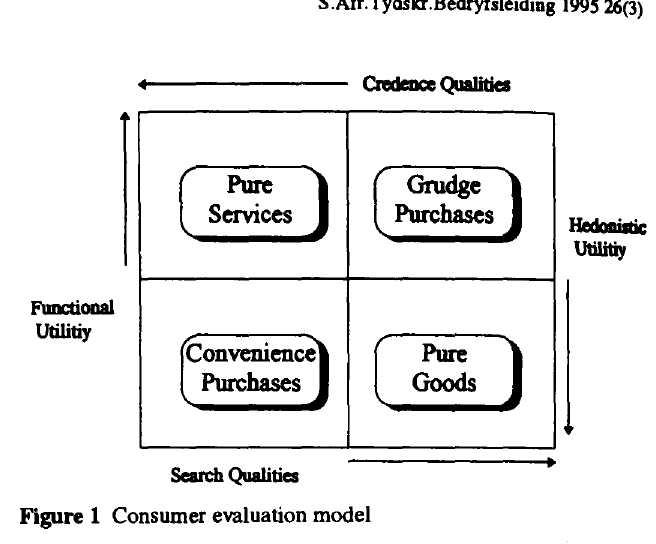
Figure 1 Consumer evaluation